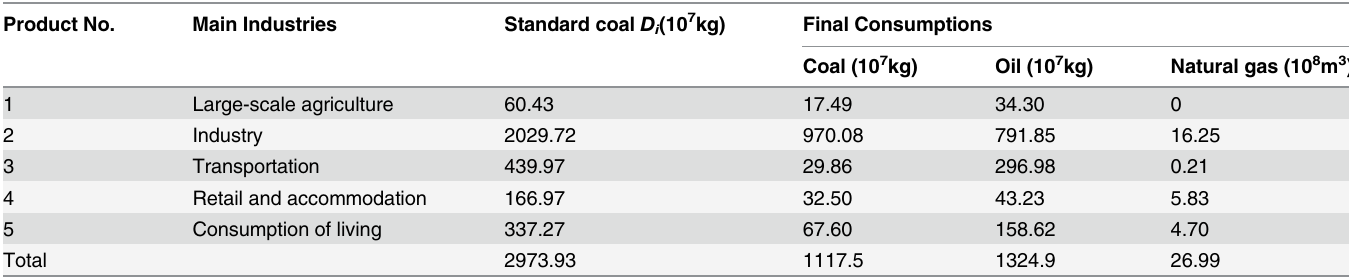
Table 3. Final Consumptions of Energies in